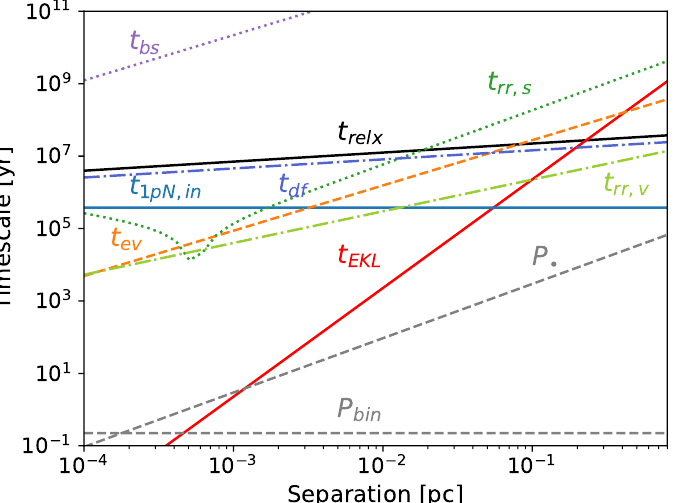
Figure 2. Timescales of several mechanisms affecting the formation of single and binary compact objects in a galactic nucleus similar to the Milky Way. Here, we assumed a binary mass M COB = 20 M and a supermassive black hole mass M SMBH = 10 6 M . Different lines identify (cid:12) (cid:12) different processes: 2-body relaxation ( t relx ), scalar ( t rr,s ) and vector ( t rr,v ) resonant relaxation, evaporation ( t ev ), dynamical friction ( t df ), binary–single scattering ( t bs ), eccentric Kozai–Lidov ( t EKL ), general relativistic precession ( t 1pN,in ), binary period ( P bin ), orbital period of the binary about the supermassive black hole ( P ). For the sake of visibility, the plot does not include the AGN lifetime • (nearly constant line, 1–100 Myr) and the three-body and gravitational wave capture (single–single) scattering time, which are much larger than all other timescales for the adopted